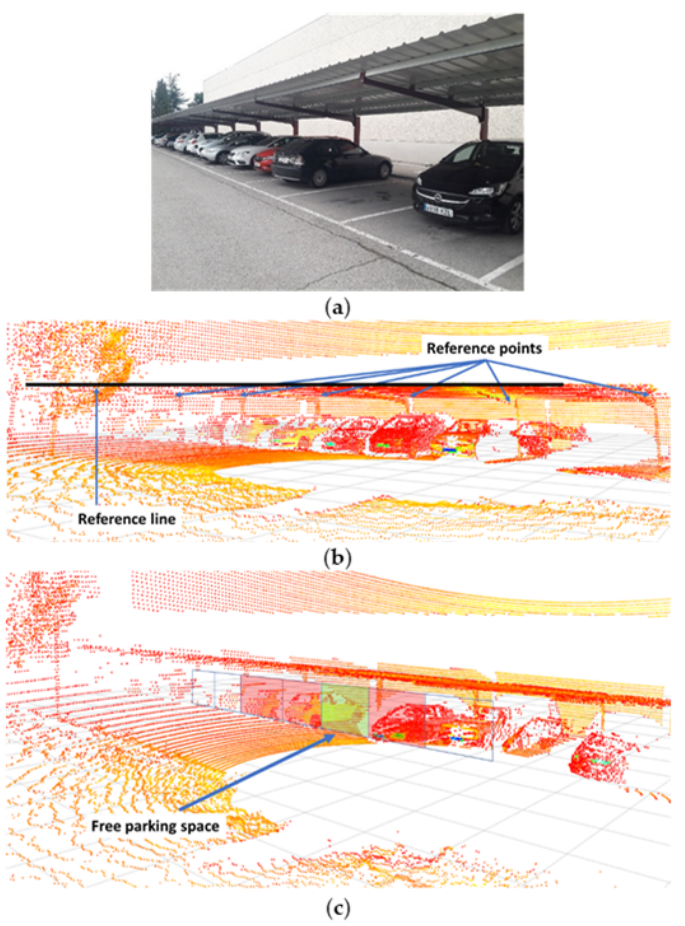
Figure 9. Detection of reference elements and free and occupied parking spaces. ( a ) Scenario; ( b ) reference element detection; ( c ) free parking spaces detection.